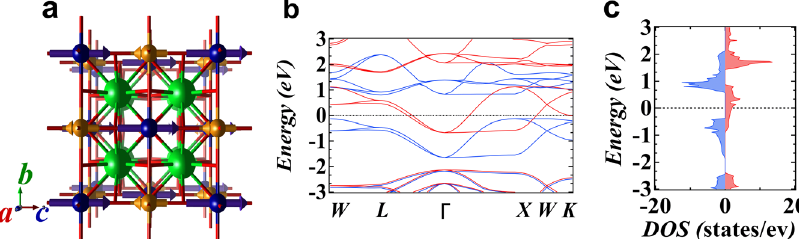
Fig. 5 Structure, electronic band structure, and density of states of the double perovskite Sr 2 CrMoO 6 . a Face-centered cubic structure of the double perovskite Sr 2 CrMoO 6 . b Electronic band structure taken on a selected path through the Brillouin zone. c Spin-resolved density of states integrated over the entire Brillouin zone showing spin-up states at the Fermi level with 100% spin